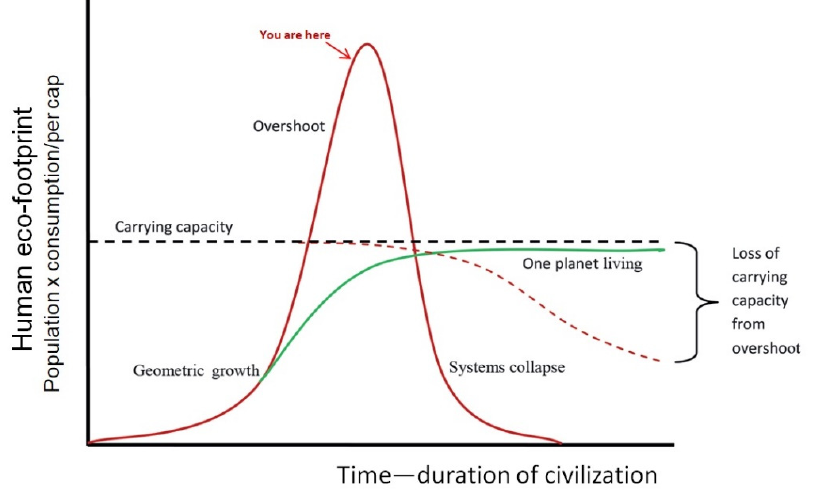
Figure 1. The human enterprise is in overshoot. We are long past the global carrying capacity, nearing the peak of an anomalous 200-year population and economic expansion enabled by fossil fuels and facilitated by improved public health (solid red line). The cost of overshoot is a reduction of long-term carrying capacity (reduced productivity of ecosystems). A more sophisticated civilization would have self-regulated to achieve “one planet living” (solid green line). The best our MTI society can do now is a controlled contraction that comes off the peak and stabilizes at or below Earth’s remaining biocapacity (dotted red line to the right).